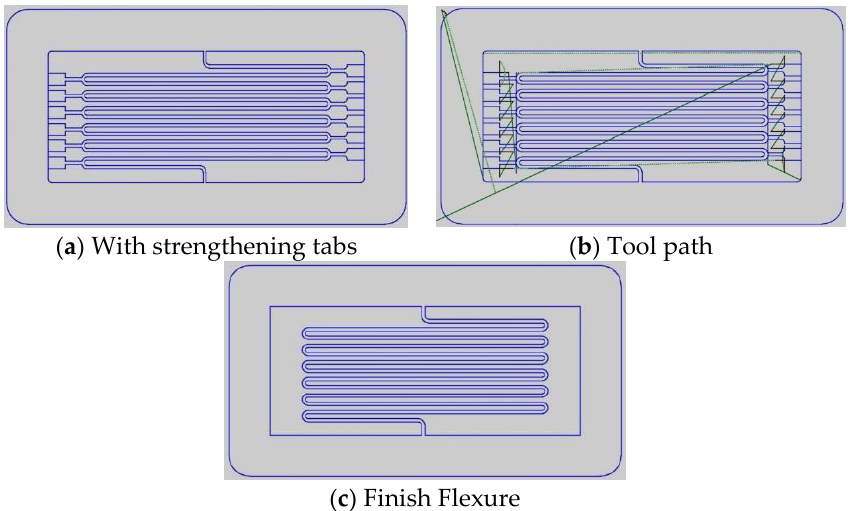
Figure 1. DXF of flexure selected as the reference part for the MicroCutting Project.